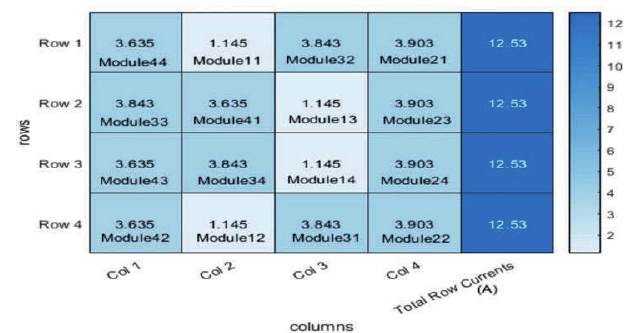
Fig. 7. Final currents (A) of panels.